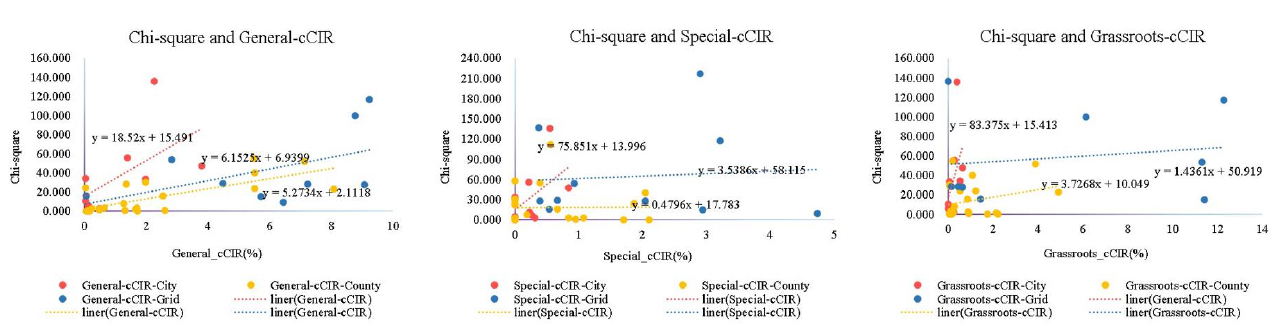
Figure 8. Infection rate and chi-square trend chart of different professions.